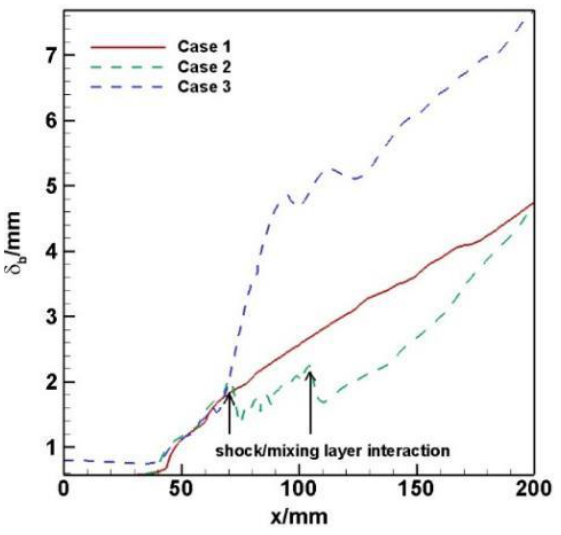
Figure 10. Comparison of velocity thickness of three cases. Because the interaction between shock wave and the mixing layer will cause the total pressure loss of the flow field, and the total pressure loss coefficient is an important index to evaluate the actual operation of the engine, we perform a detailed analysis of the total pressure loss coefficient, which is defined as,